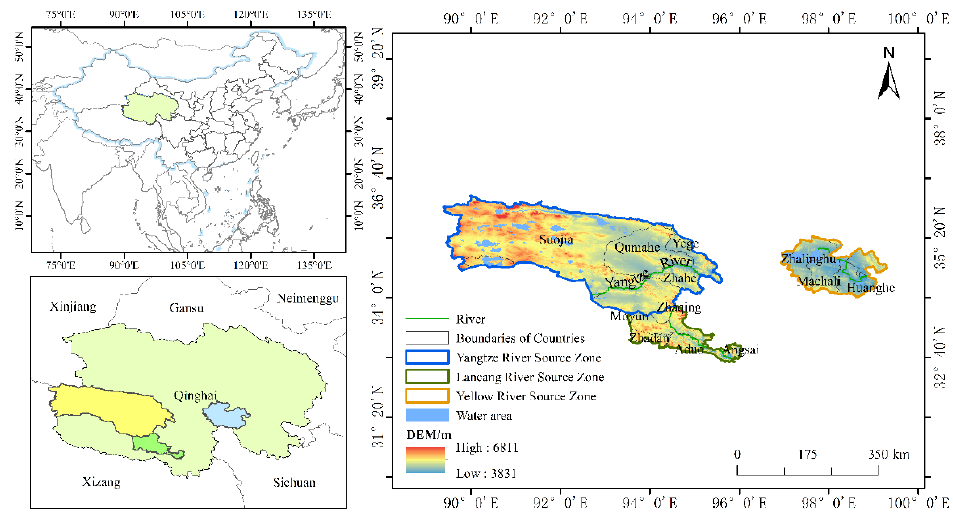
Figure 1. Location of the Three-River-Source National Park (TNP), China.